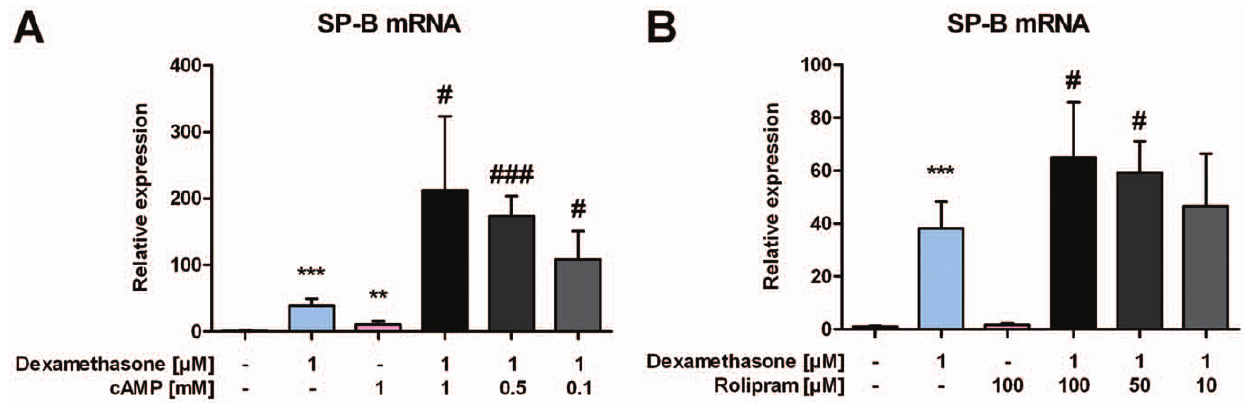
Figure 3. Enhanced expression of SP-B mRNA after accumulation of cAMP. H441 cells were treated as indicated, and 24 h later qPCR of SP-B mRNA was performed. SP-B mRNA levels were normalized to b -actin, and fold differences compared to untreated cells were calculated. ( A ) H441 cells were treated with dexamethasone, cAMP, or different concentrations of cAMP in combination with dexamethasone. ( B ) H441 cells were treated with dexamethasone, the PDE inhibitor rolipram, or different concentrations of rolipram in combination with dexamethasone. Means 6 SD of at least n=3 independent experiments are shown. ** p , 0.01 and *** p , 0.001 compared to control cells, # p , 0.05, ### p , 0.001 compared to cells treated with